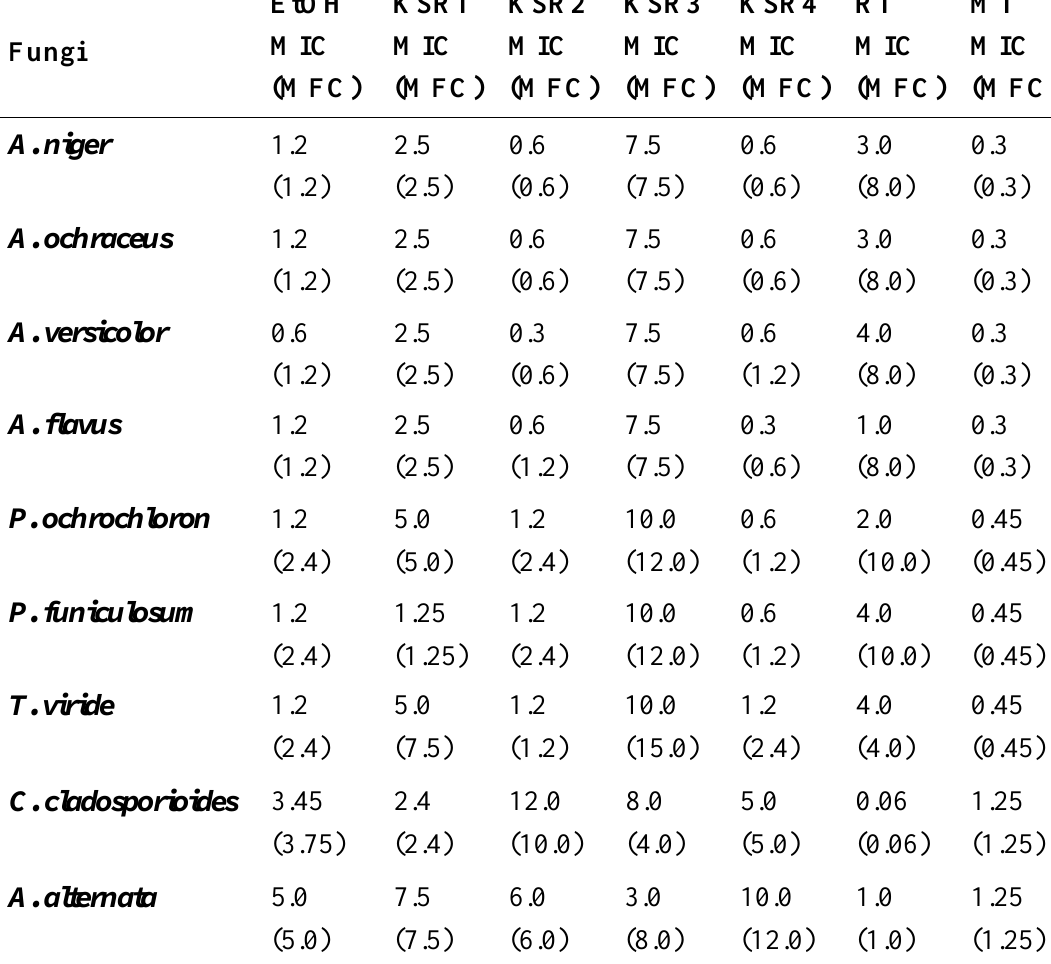
Table 4 : Minimum inhibitory concentrations (MICs) and minimum fungicidal concentrations (MFCs), nmol/mL. MICs and MFCs are presented as mean values.